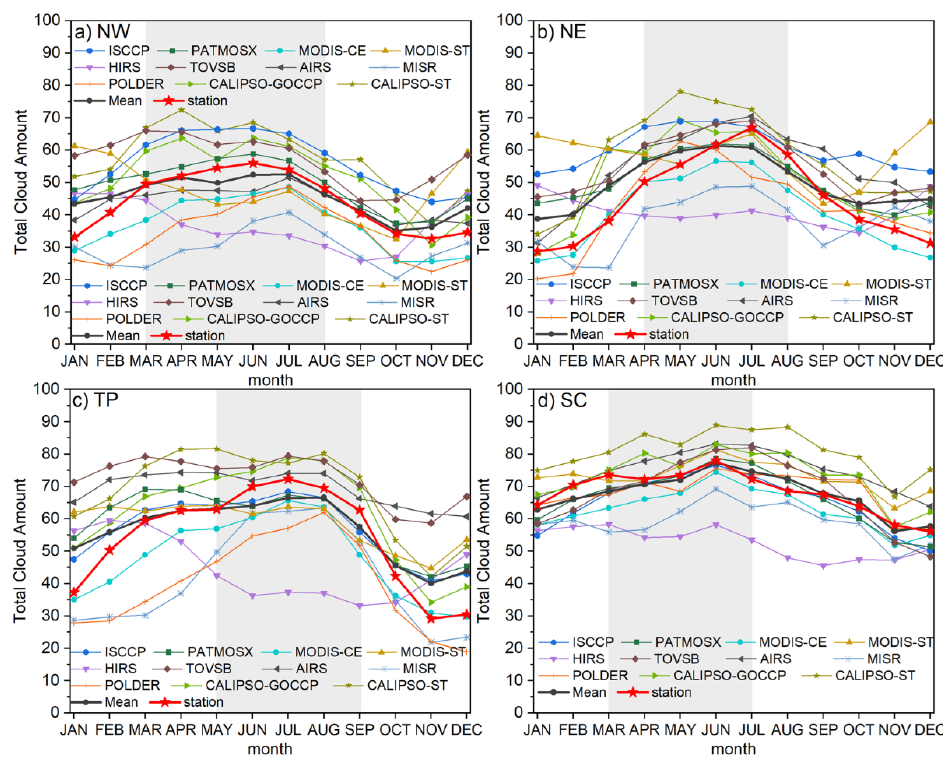
Figure 8. The seasonal cycle characteristics of TCA in different regions of China. The station represents the observation data of the station, and the shading indicates the month of the peak. ( a ) NW region; ( b ) NE region; ( c ) TP region; and ( d ) SC region. The thick red line with a red pentagram is for station observation data.